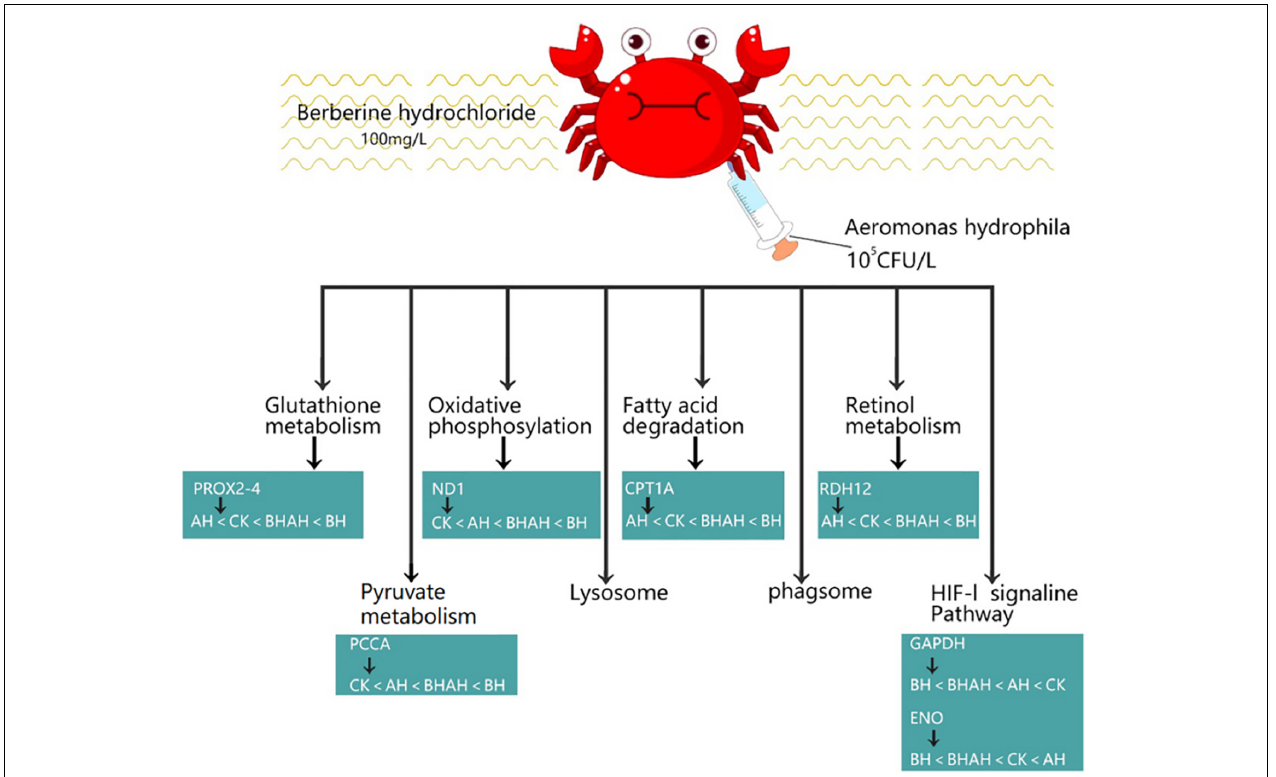
FIGURE 10 | Molecular mechanism of berberine hydrochloride in C. japonica injected with 10 5 CFU/L A. hydrophila